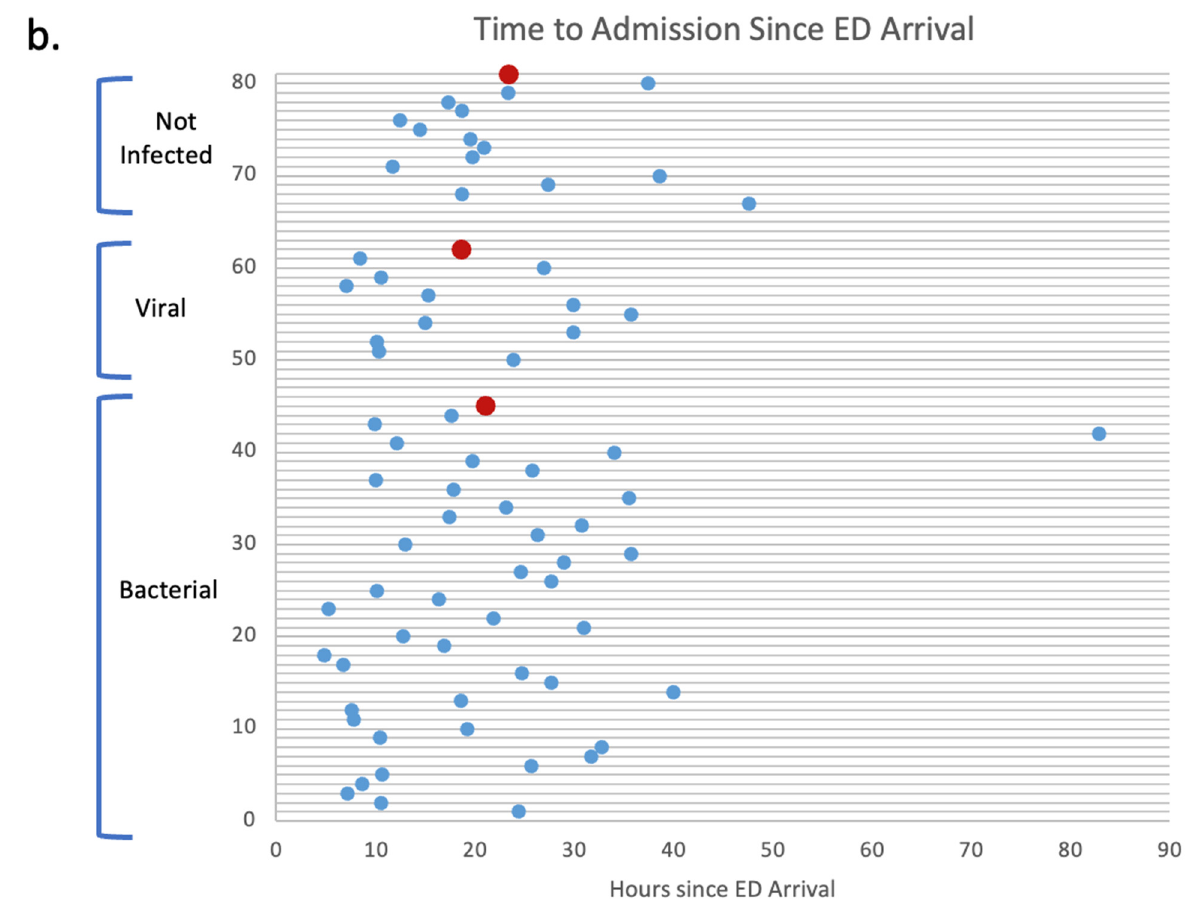
Figure 8. ( a ) Primary care pathways for the FP, and FN groups from ED arrival to admission represent the time to first labs, first cultures, first imaging, and first antibiotics. Large circles with black borders represent average hours. Small circles represent the timepoints for each subject for the FP and FN groups. ( b ) Average time from ED arrival to admission for the FP and FN groups. Red circles represent average hours for time to admission. Blue circles represent the time from ED arrival to admission for each subject for the FP and FN groups.